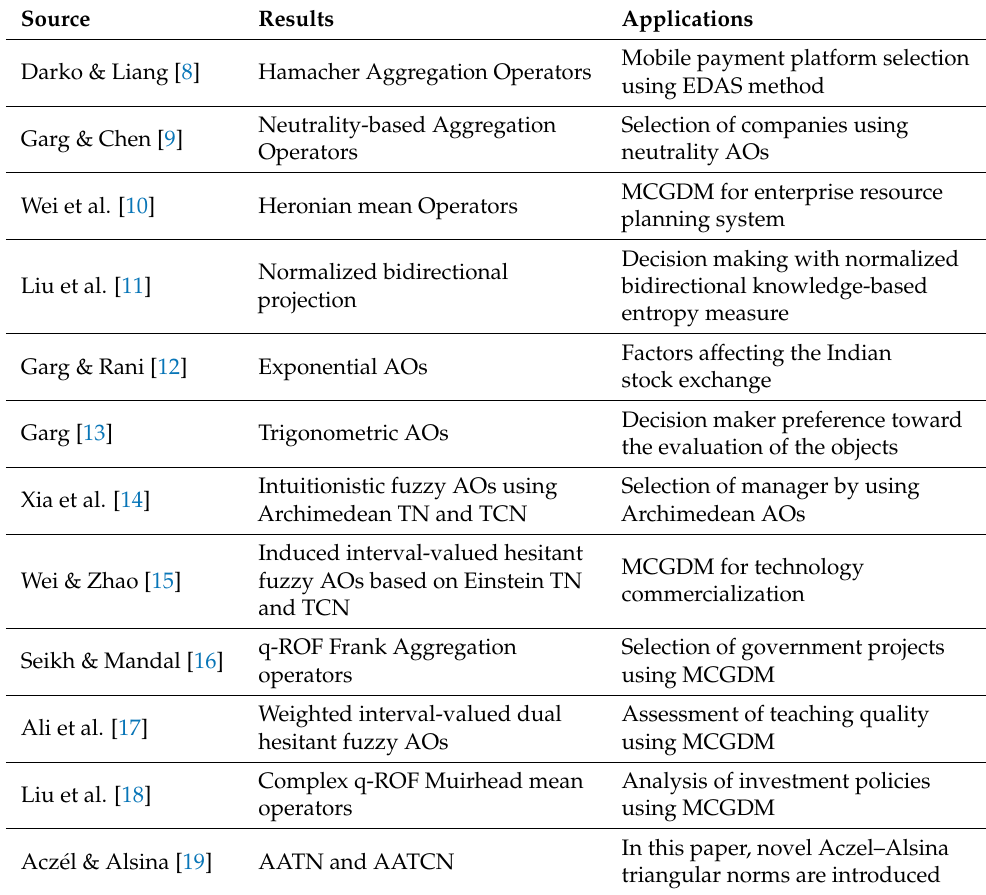
Table 1. Literature review concerning MCGDM